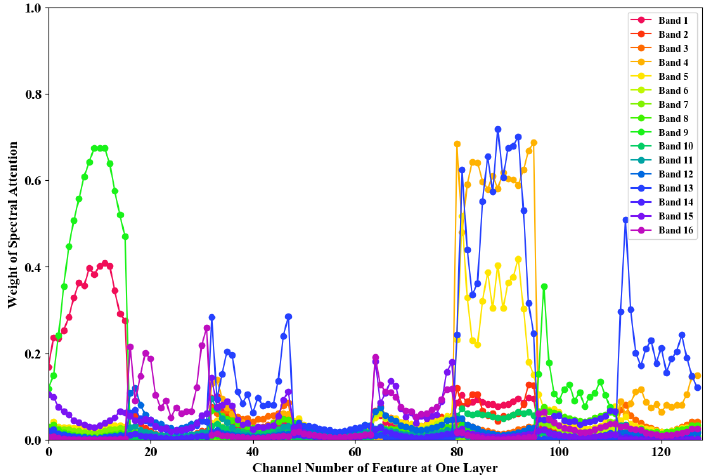
Figure 9. The line chart of kernel weight learned by SCA. The network extracts the four most important bands, i.e., band 1, band 4, band 5, and band 9. The high weights of band 9 and band 4 are concentrated between [0, 20] and [80, 100], respectively, indicating that the attention of the network is relatively concentrated. Feature maps (see more details in Section 4.2) also show that the feature types in the connected interval are